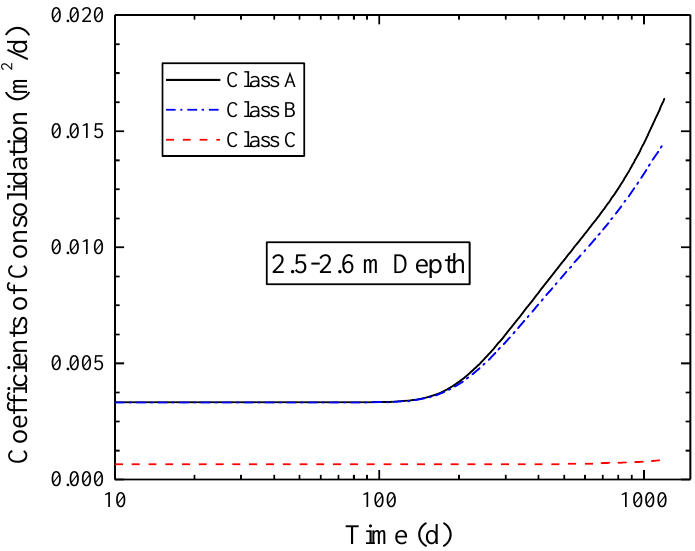
ffi cients of consolidation at 2.5–2.6 m depth. Figure 10. Comparisons of coefficients of consolidation at 2.5 – 2.6 m depth. Figure 10. Comparisons of coe